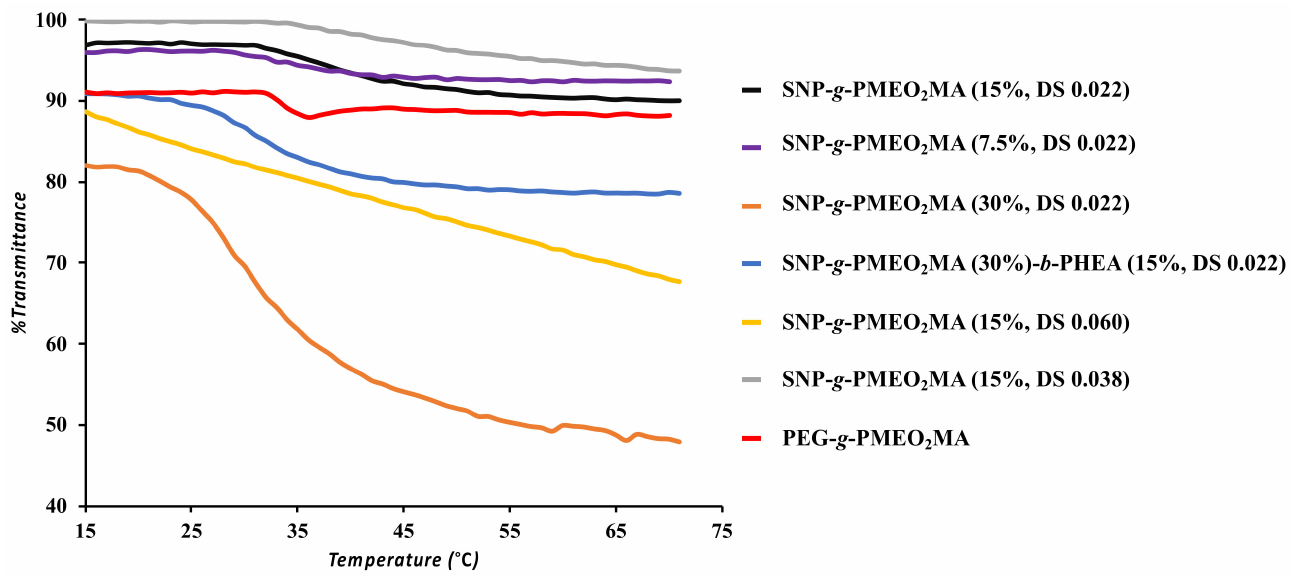
Figure 4. Transmittance curves as a function of temperature for the polymer-grafted